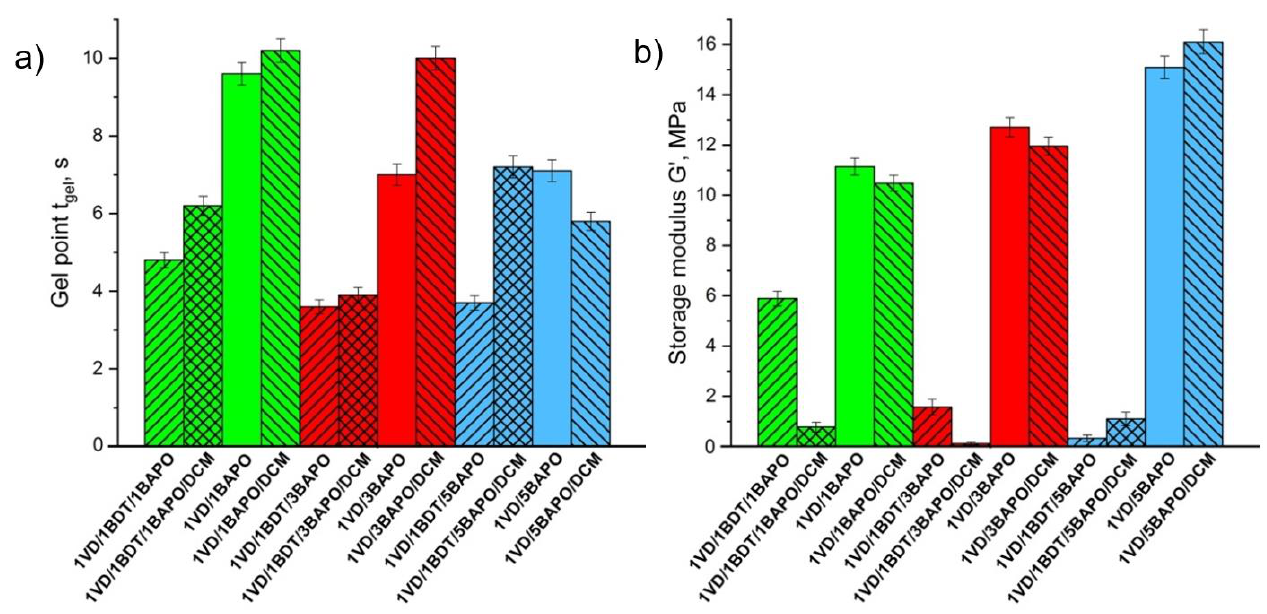
Figure 5. Gel point t gel ( a ) and storage modulus G ’ ( b ) of the VD-based resins. Green columns—1 mol% of BAPO; red columns—3 mol% of BAPO; blue columns—5 mol% of BAPO; leaning lines from bottom to top—presence of BDT; leaning lines from top to bottom—presence of DCM.